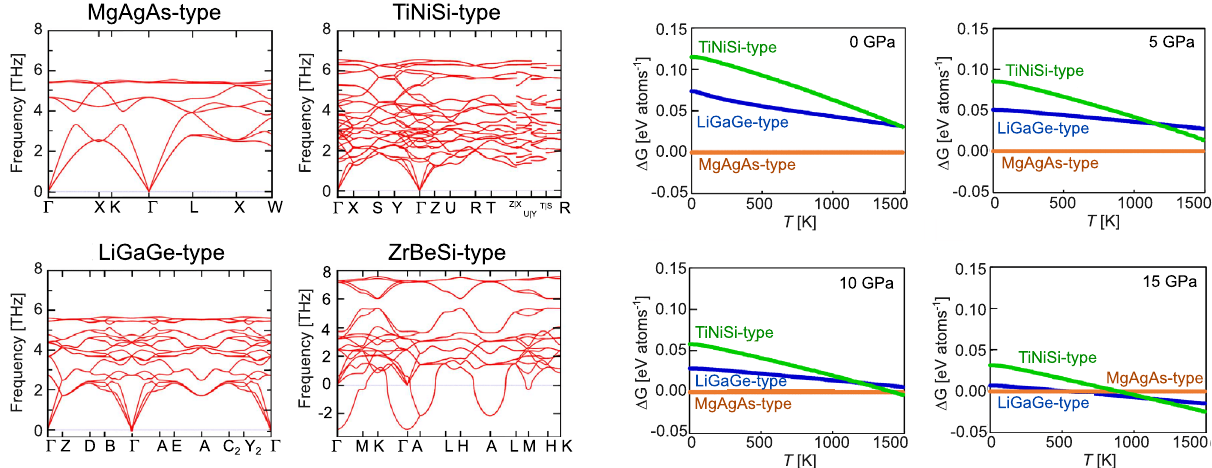
Figure 6. Left panel: phonon dispersion relations for MgAgAs-type, TiNiSi-type, LiGaGe-type, and ZrBeSi- type polymorphic modifications of TmNiSb; Right panel: Temperature variations of Gibbs energy for constant pressures 0–15 GPa.